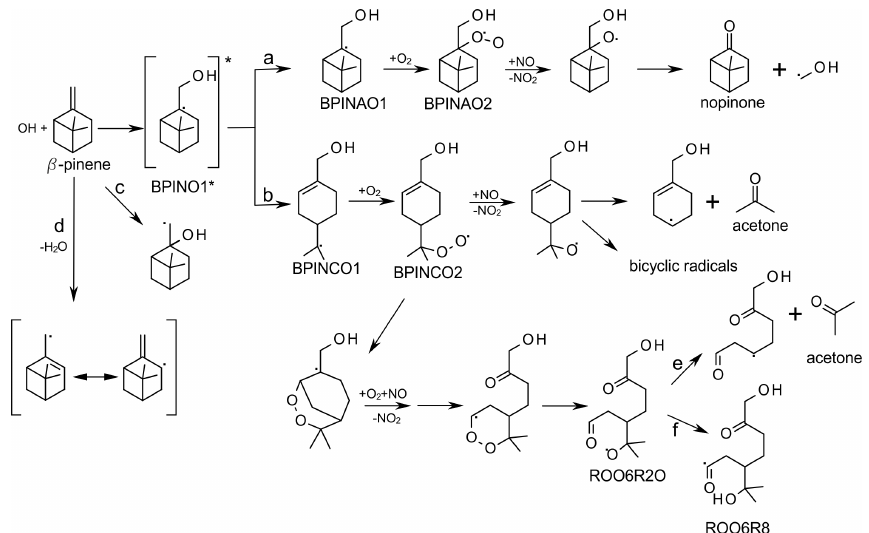
Figure 1. Acetone and nopinone formation from OH-initiated β -pinene oxidation after Vereecken and Peeters (2012). For simplification only the major reactions are